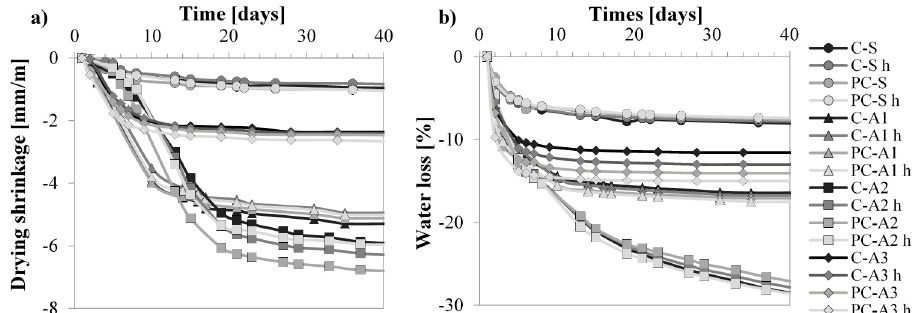
Figure 4. Mortars exposed at RH = 50% and T = 20 °C: ( a ) drying shrinkage; ( b ) water loss.